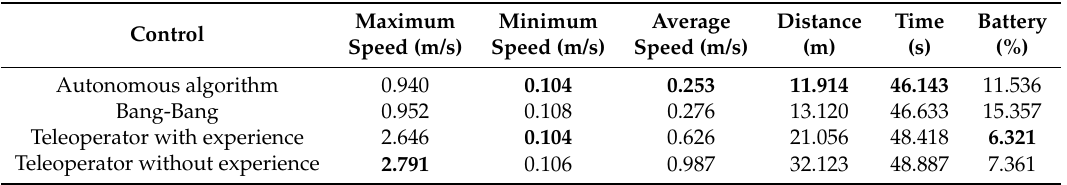
Table 3. Three fixed